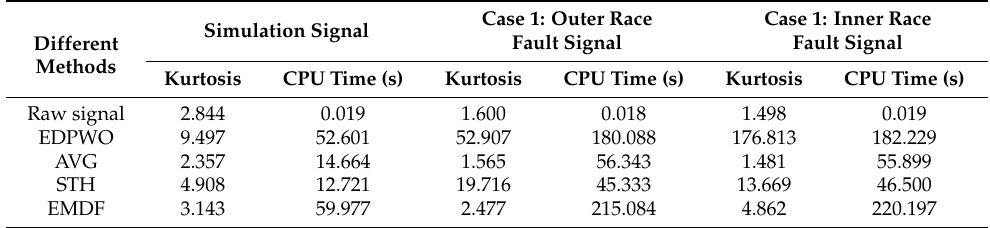
Table 9. The FFR value obtained by various methods under different CWRU fault data.